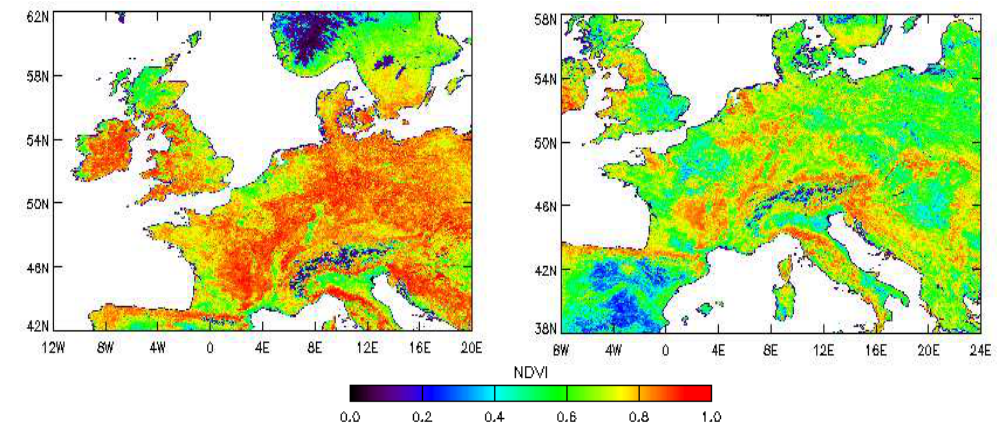
Fig. A1. NDVI maps on 21 May 2001 for CAATER 1 (left) and on 1 October 2002 for CAATER 2 (right).